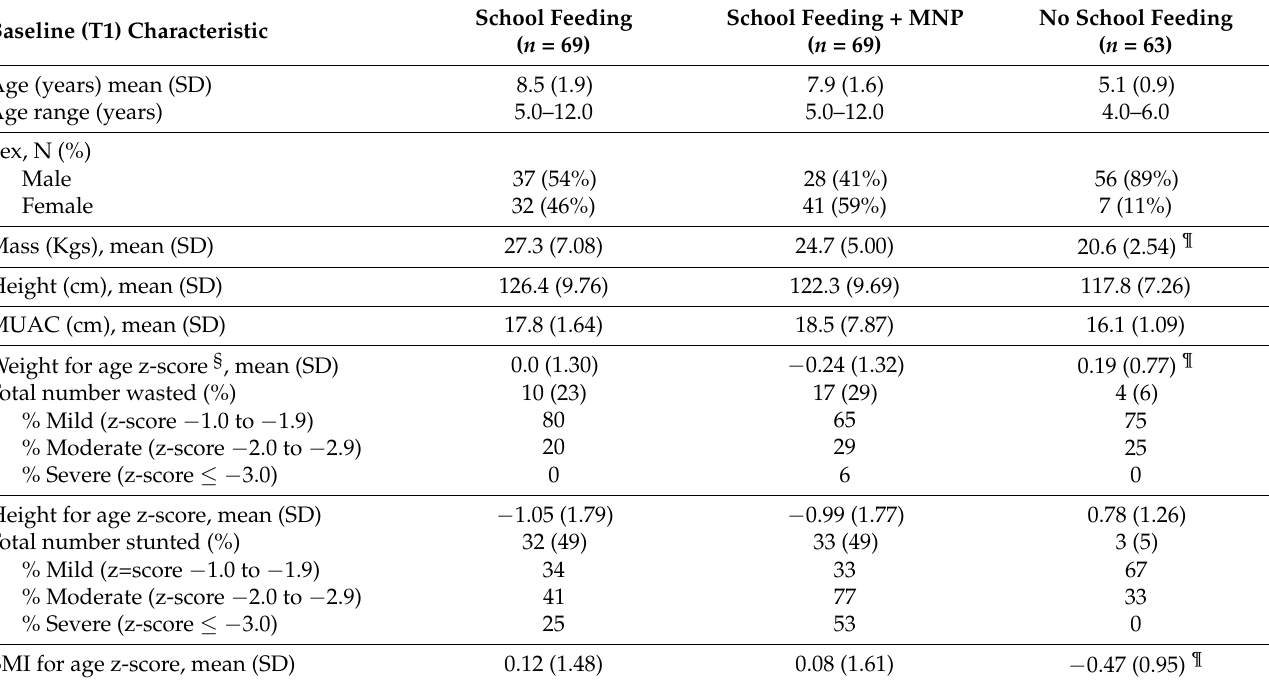
Table 3. Baseline characteristics of the children that were included in the RCMT analyses.